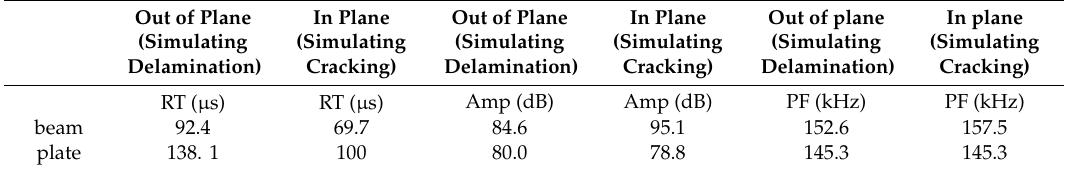
Table 1. Basic waveform descriptors under di ff erent excitation in beam and plate geometry.